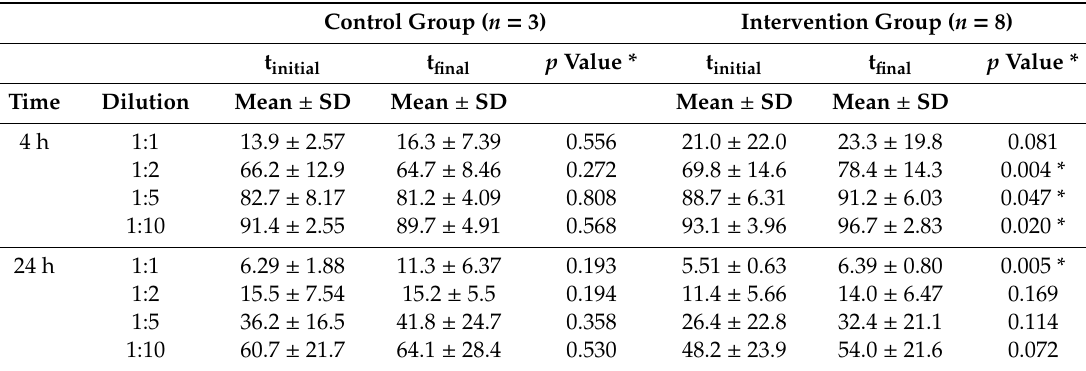
Table 2. Viability (% with respect to the control) of HT-29 cells after exposure to faecal water (FW) from the control and intervention groups before (t initial ) and after (t final ) wine consumption. Data represent the mean and standard deviation (SD) of three independent experiments, each analysed in triplicate.